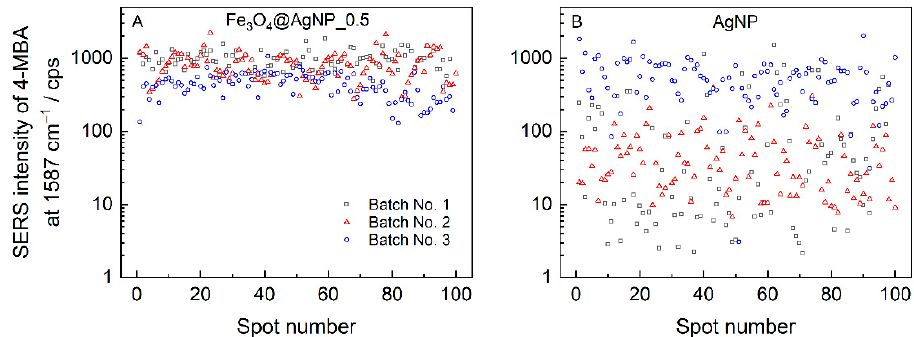
Figure 7. The intensity distribution of the dominant 1587 cm –1 band was obtained from 100 spectra of 4-MBA adsorbed on ( A ) Fe 3 O 4 @AgNP_0.5 and ( B ) AgNPs. Nanoparticles were dried while placing a glass slide in a strong magnetic field. Spectra were excited at 532 nm with 45 μ W laser power focused to a spot on a surface of 1 μ m in diameter and 12 s acquisition time. Three different preparations of Fe 3 O 4 @AgNP_0.5 and AgNPs are analyzed.